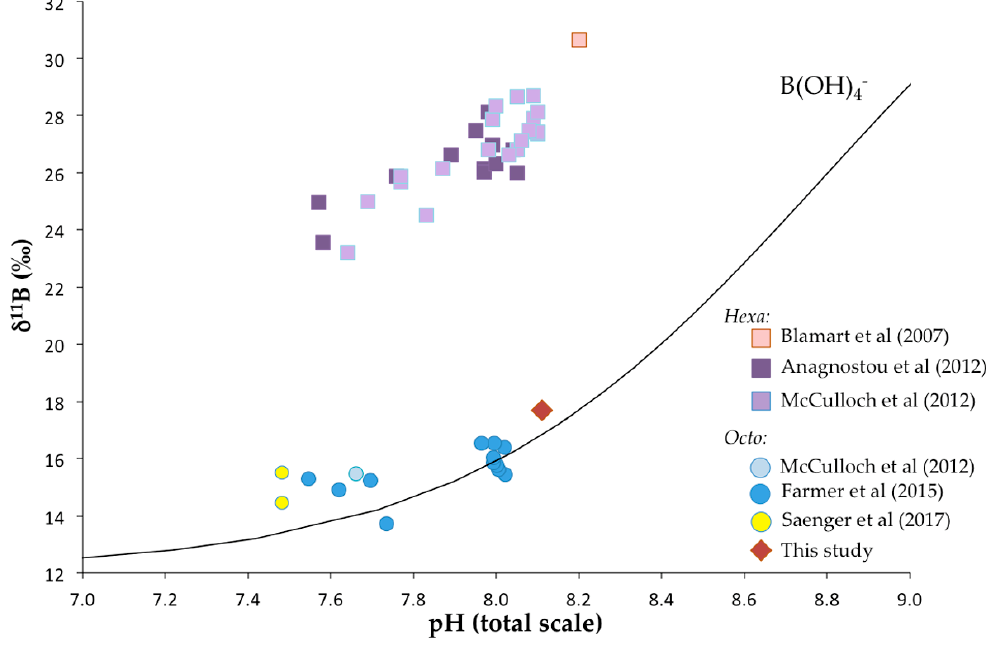
Figure 12. The δ 11 B values of scleractinian and octocorallian coral as a function of seawater pH. The black line represents the boron isotopic composition of borate ion calculated with the isotopic fractionation factor of Klochko et al. [78]. The circles represent literature data for octocorallian coral [22,58,85] and squares are for data of scleractinian deep-sea corals [27,85,88]. Note that the data from [27] were corrected with a revisited value of the standard (i.e., δ 11 B = 17.8‰). The diamond is the average δ 11 B value of this study for Terrasses sample. The pH value for Terrasses sampling location is from IFREMER oceanic data (pH = 8.11 ± 0.05).